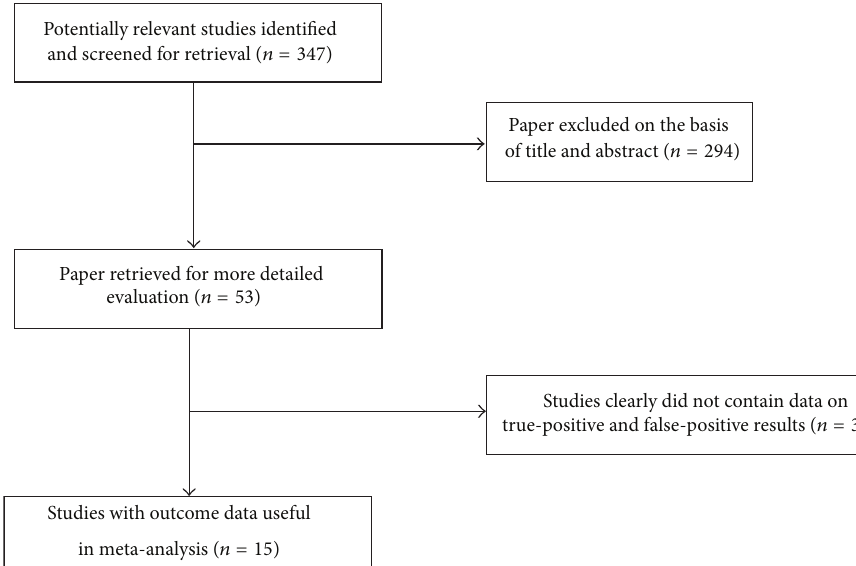
Figure 1: Summary of study assessment and inclusion in the meta-analysis of studies involving diagnosis of neonatal sepsis using a TNF- 𝛼